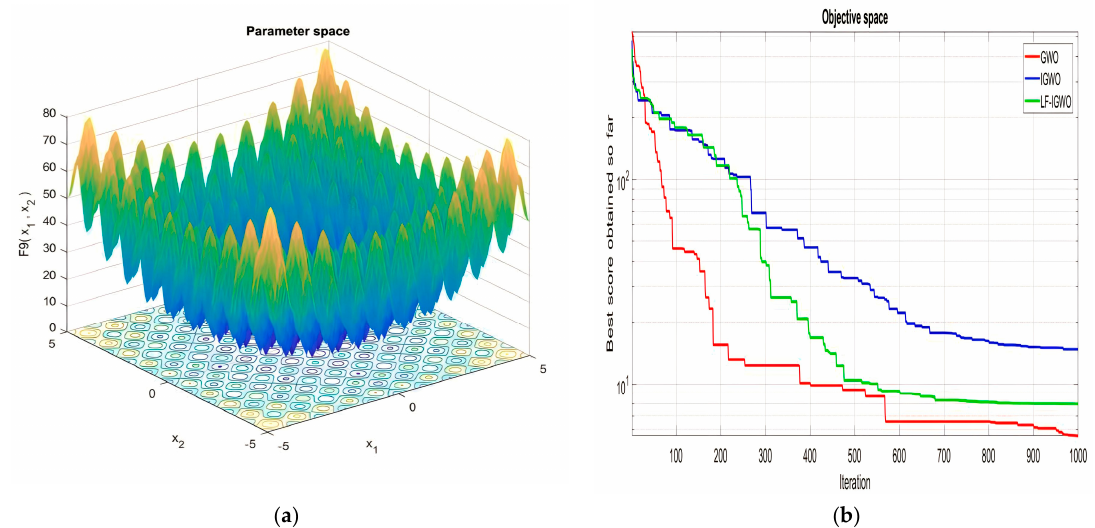
Figure 11. ( a ) Search space for multi model function F09 ( b ) Comparison of convergence curve for F09.